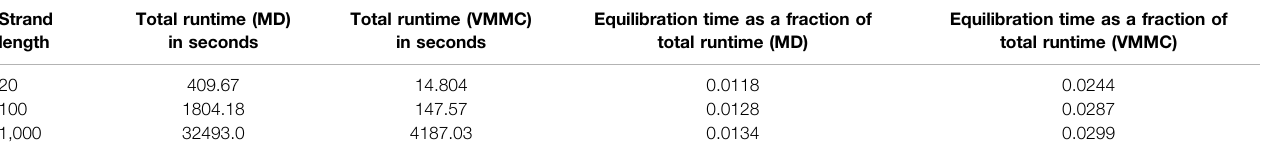
TABLE 1 | Computational time for equilibration of poly (dT) molecules of various lengths. Simulations were performed using a single core Intel(R) Core(TM) i5-4300U CPU @ 1.90GHz. Strand